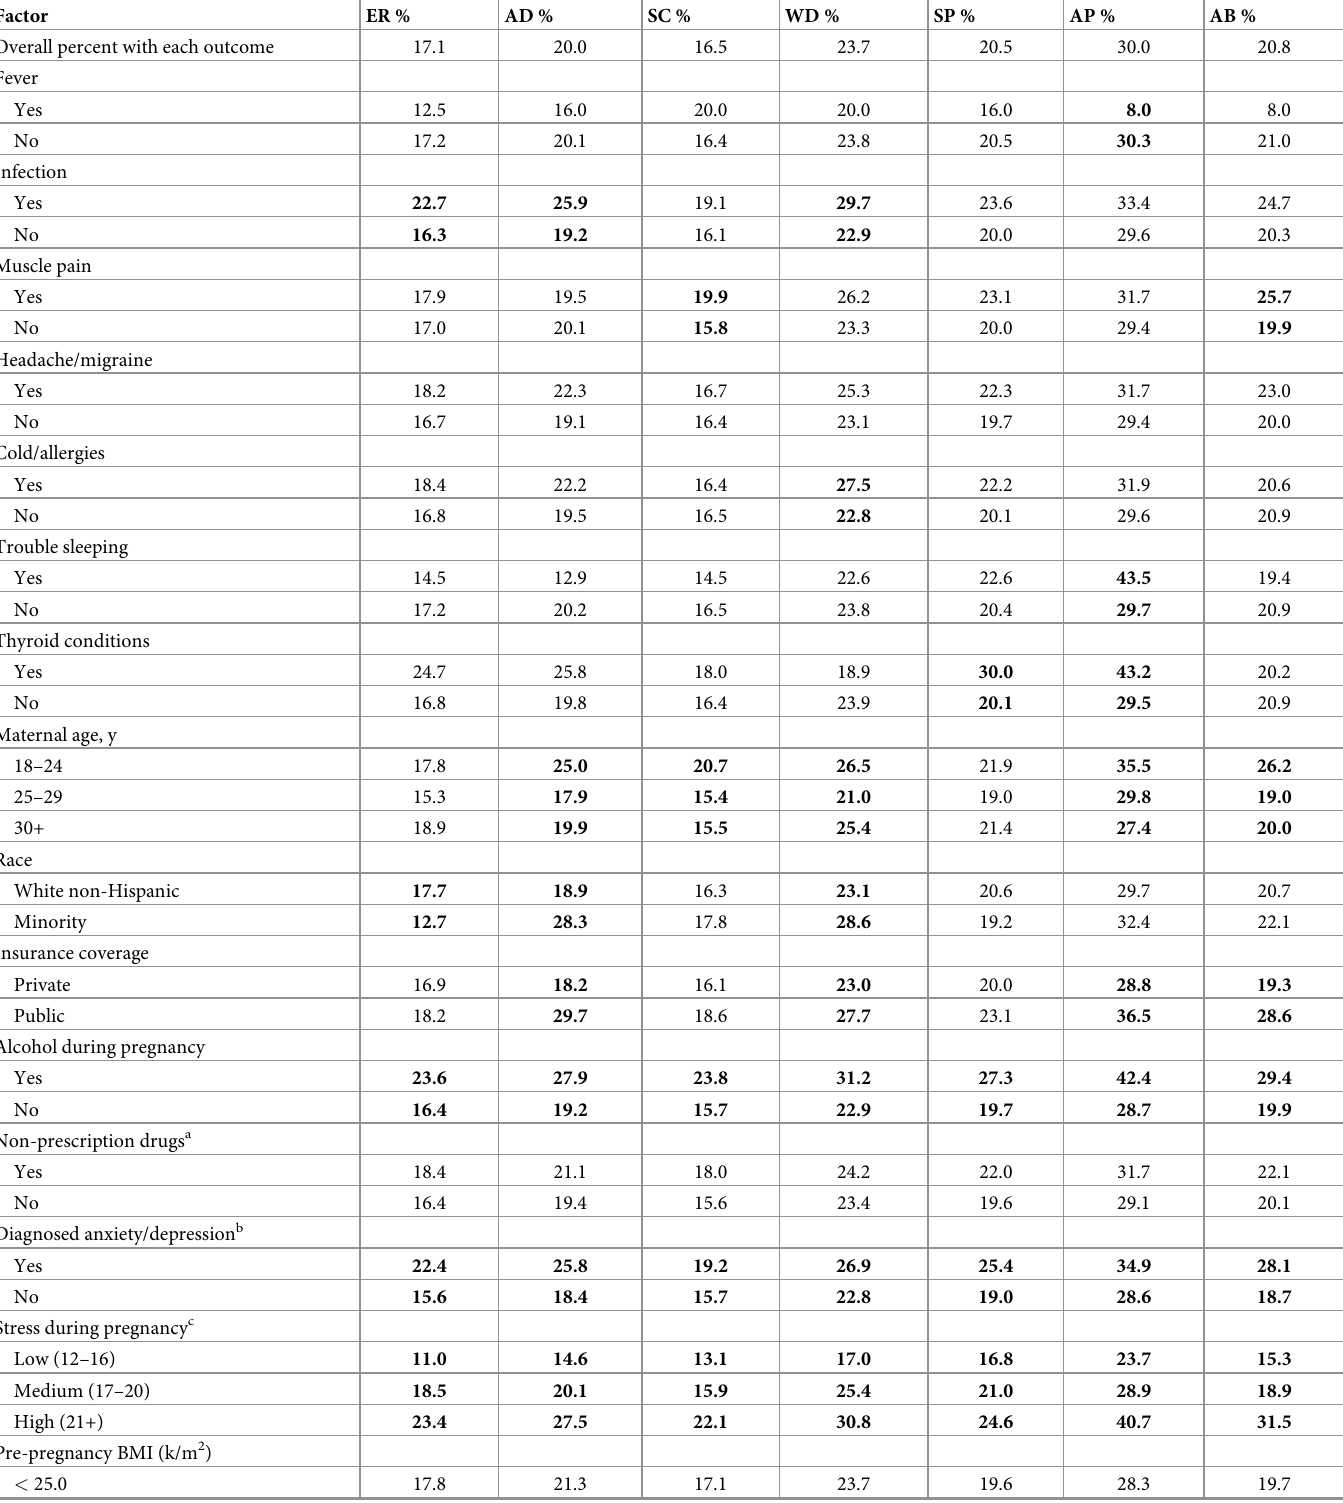
Table 2. Association of potentially confounding variables with each of the CBCL syndrome scale outcomes. (Percent with each outcome shown). Factor ER % AD % SC % WD % SP % AP % AB % Overall percent with each outcome